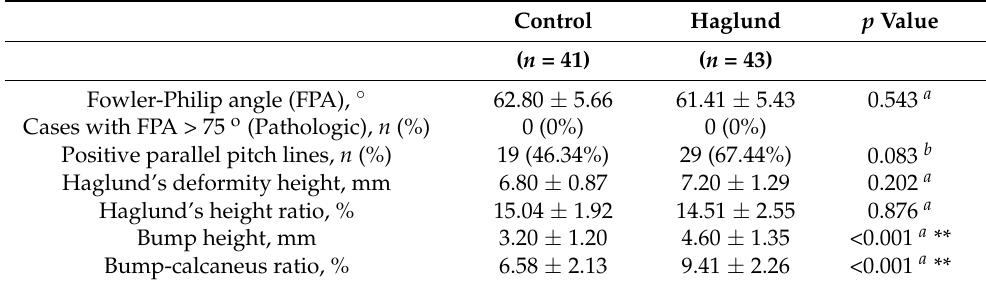
Table 2. A comparison of X-ray parameters for the diagnosis of Haglund’s deformity between the Haglund and control groups.